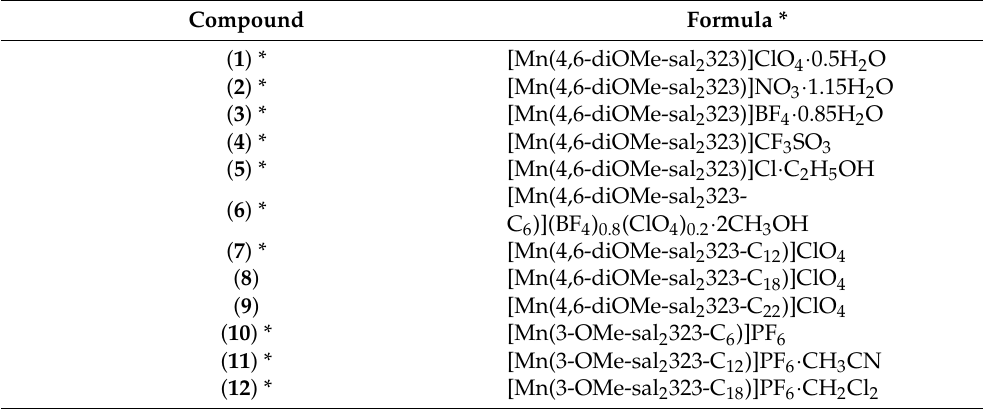
Table 1. Mn(III) complexes with 4,6-diOMe-sal 2 323 and related alkylated ligands.